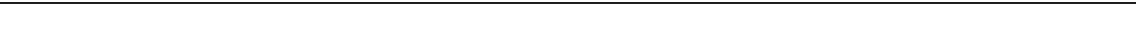
Fig. 2 Genomic subtypes of urologic cancers in TCGA cohort by analysis of multiple data platforms. a Integration of subtype classi fi cations from fi ve “ omic ” data platforms identi fi ed nine major groups of urologic cancers being represented in TCGA ( n = 1954 cases, including bladder, renal clear cell, renal chromophobe, renal papillary, prostate, and testicular cancers). The heat map displays the subtypes de fi ned independently by DNA methylation ( pink ), Chromosomal copy alteration ( black ), mRNA expression ( red ), microRNA expression ( blue ), and protein (RPPA) expression ( green ); each row in this heat map denotes membership within a speci fi c subtype de fi ned by the indicated platform. Data points are colored according to pan-urologic subtype (Table 1). b Differential gene expression patterns (values normalized within each main cancer type), representing a set of genes that help to distinguish between the nine subtypes (for each subtype, showing the top 100 genes most differentially in the given subtype vs. the rest of the tumors). c DNA methylation patterns, with heat map representing the top 2000 genomic loci with the highest variability in DNA methylation patterns across tumors (using a data set with methylation values being normalized within each main cancer type), and with corresponding p16 silencing and CDKN2A copy loss indicated, along with a plot of total DNA methylation index values (fraction of methylation probes with beta > 0.3) for each sample. d By TCGA project and genomic subtype (where projects were highly represented within a given subtype), total DNA methylation index values. Box plots represent 5%, 25%, 50%, 75%, and 95%. P -values by Mann-Whitney U-test. See also Supplementary Fig. 2 and Supplementary Data 1 through